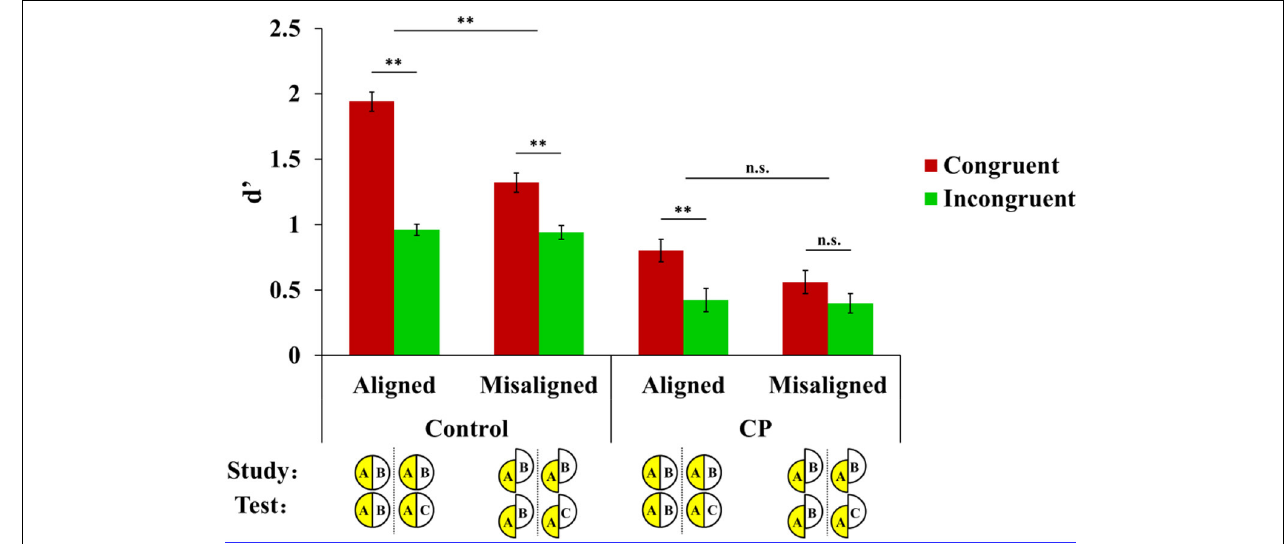
FIGURE 3 | Mean performance ( d (cid:2) ) for the control group (left) and CP participants (right) on congruent and incongruent trials for aligned vs. misaligned faces. Note that although the schematic display shows the